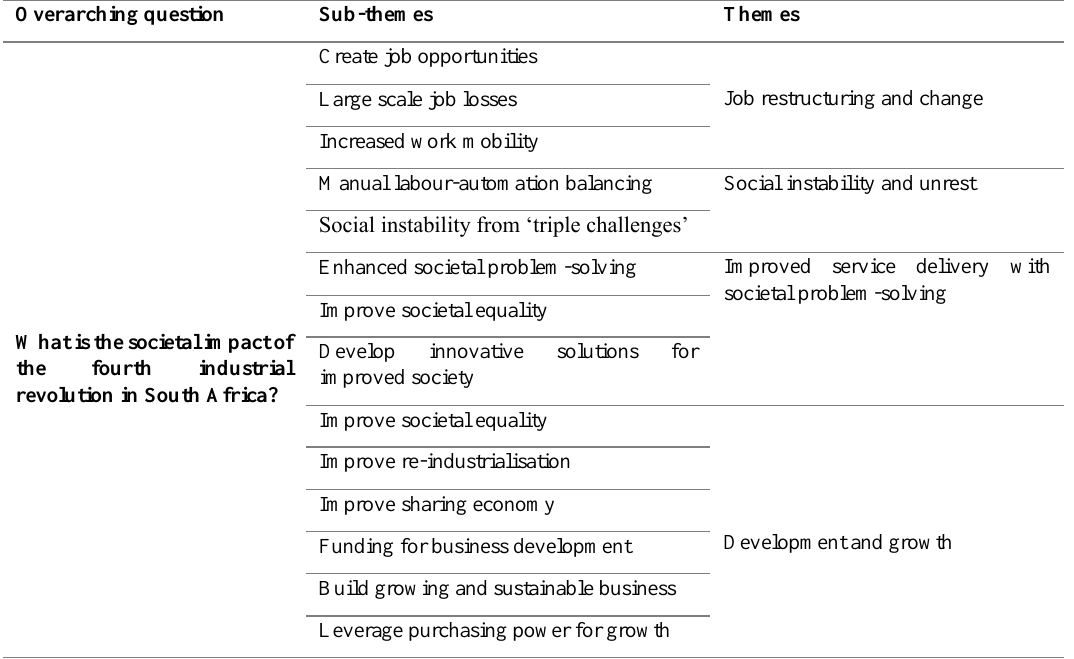
Table 1: Subthemes and themes developed from the round table focus group Overarching